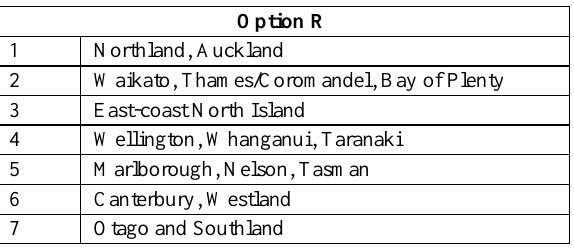
Table 4. Potential regional primary structure